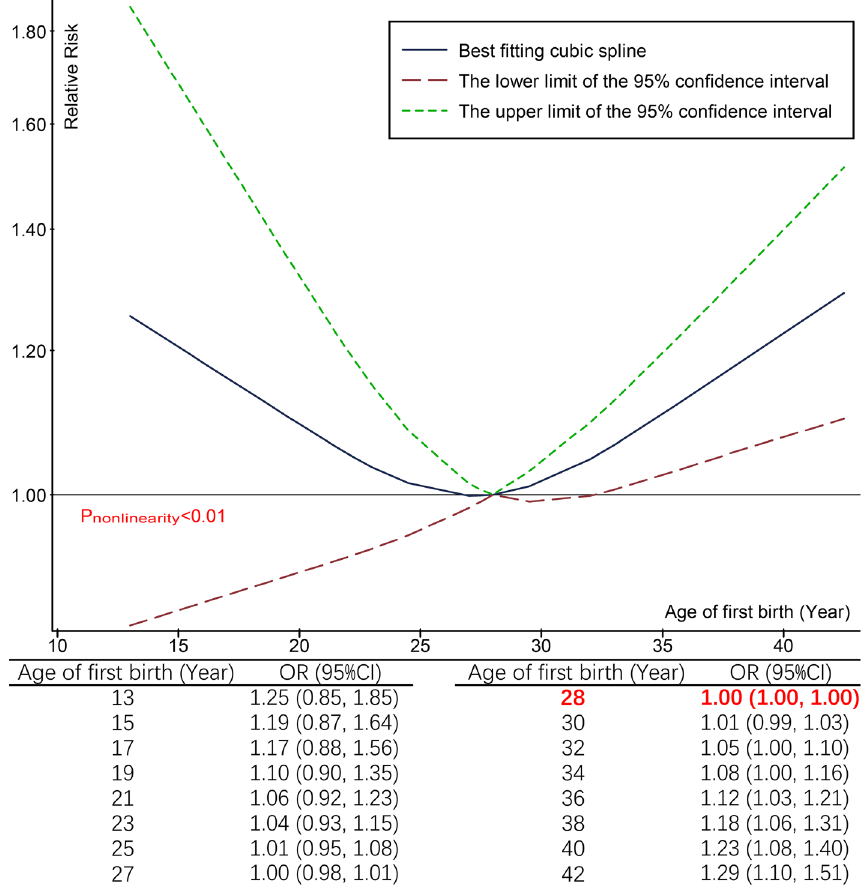
Figure 3. Linear dose–response association between age at first of birth and UI modeled with restricted cubic splines and comparison of the predicted odds ratio point estimates for